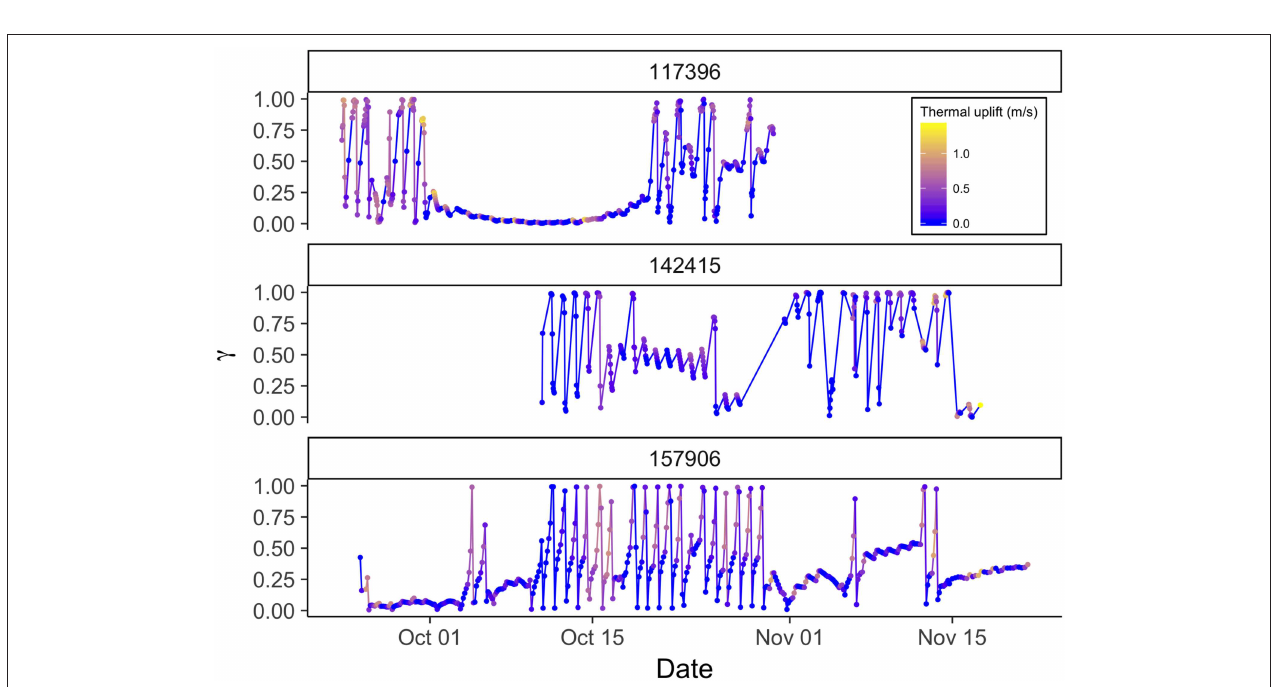
FIGURE 2 | Time series of behavior parameter γ from correlated random walk model with full behavioral process (orographic uplift, thermal uplift, and wind support as predictors) for three golden eagles during fall migration with PTTs reporting on different duty cycles. Upper panel is 13 hourly centered on solar noon plus one at midnight, middle panel is 8 hourly centered on solar noon, and lower panel is fixed 3-h interval. γ close to one reflect movements associated with migratory behavior, and γ close to zero stopover behavior. Points are times of observations, and lines are linear interpolations between points. Hue indicates intensity of thermal uplift, with yellow indicating greater thermal uplift and blue lower. Note the daily rhythm in behavior and extended stopovers as well as periods intermediate values suggesting